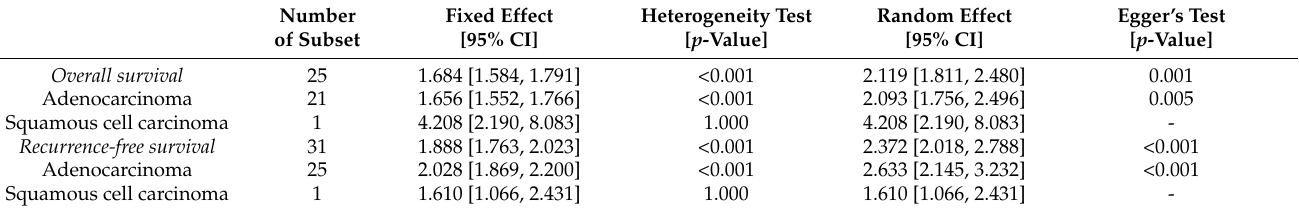
Table 5. Comparisons of prognosis between lung cancers with STAS and non-STAS. Number of